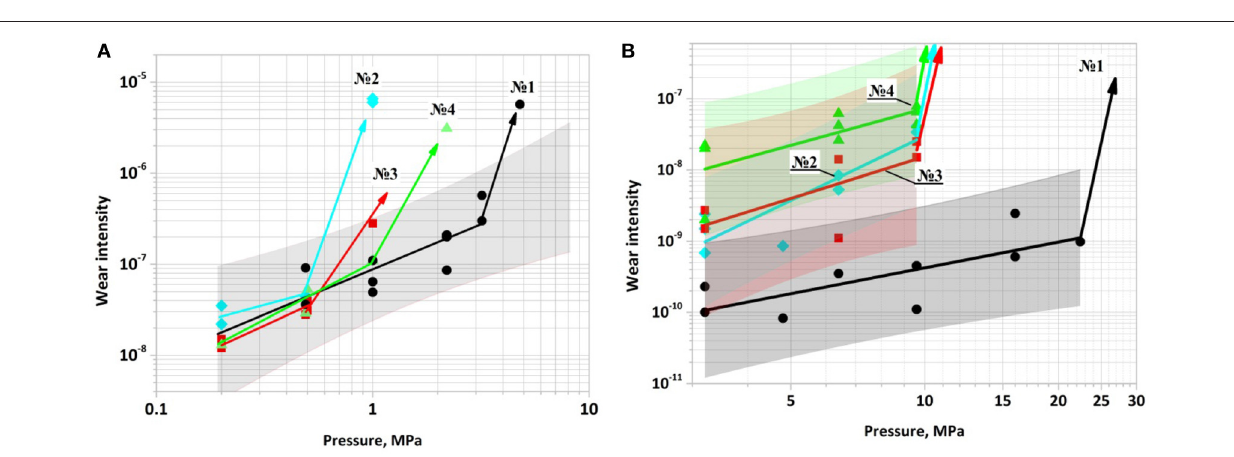
for two cases, without lubrication and with lubrication, are presented in the graphs ( Figure 2